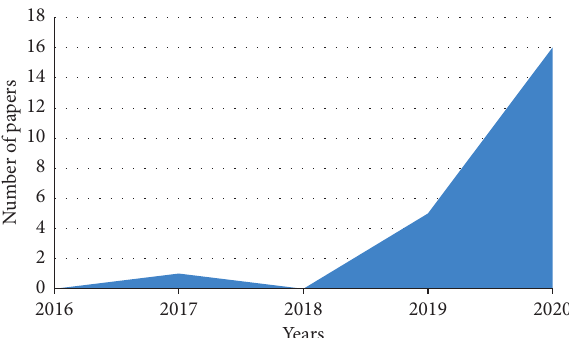
Figure 5: Articles published in the specified years.